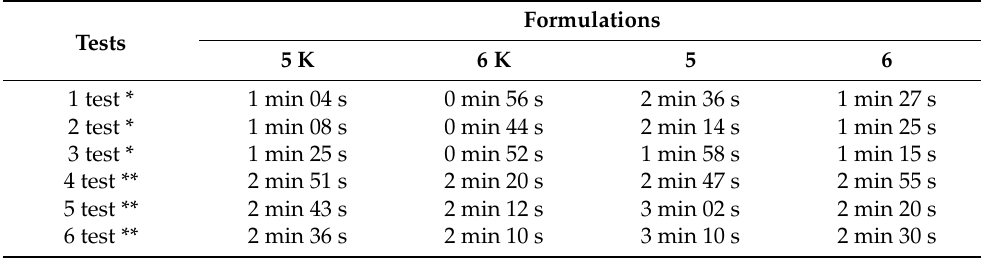
Table 2. Results of the drying rate of films with different compositions.